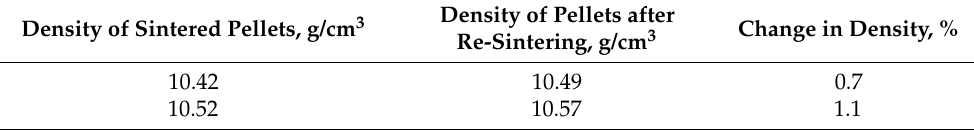
Table 2. Re-sintering of ceramic